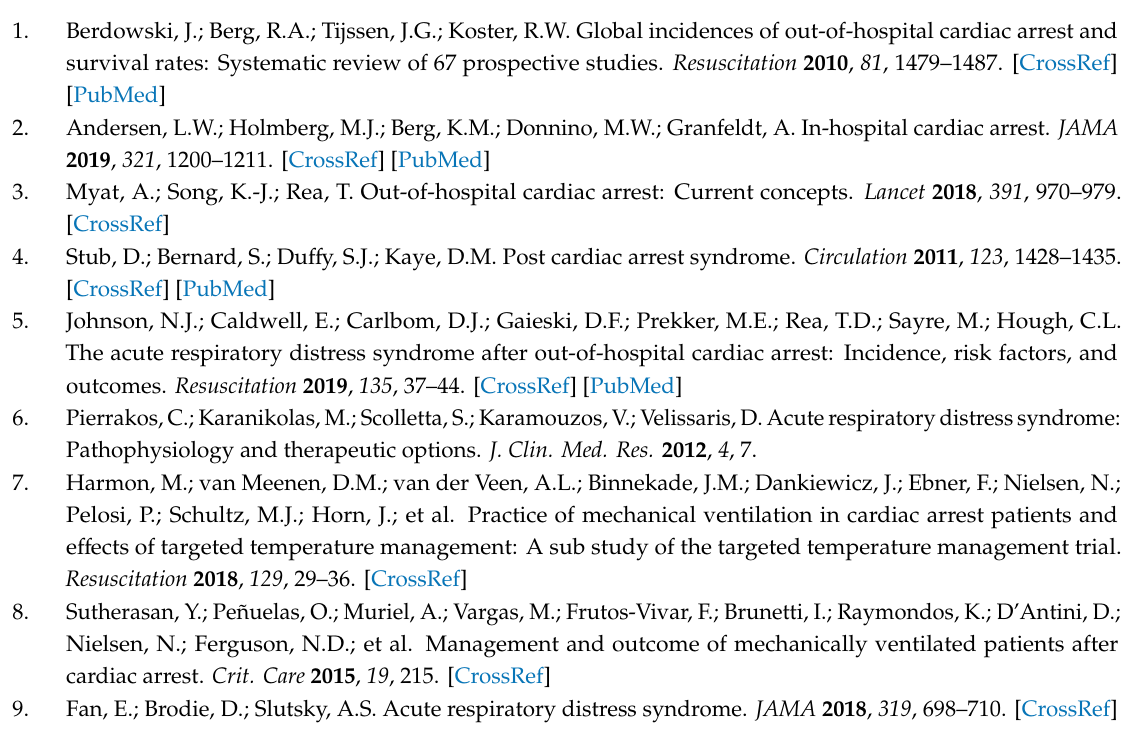
Table S1: Comparisons of mechanical ventilator parameters in the ARDS patients. Table S2: Baseline characteristics of the whole study population. Table S3-1. Baseline characteristics of the ARDS patients. Table S3-2. Comparisons of ABGA and mechanical ventilator parameters on admission in the ARDS patients. Table S3-3. Multivariate logistic regression of parameters associated with favorable neurologic